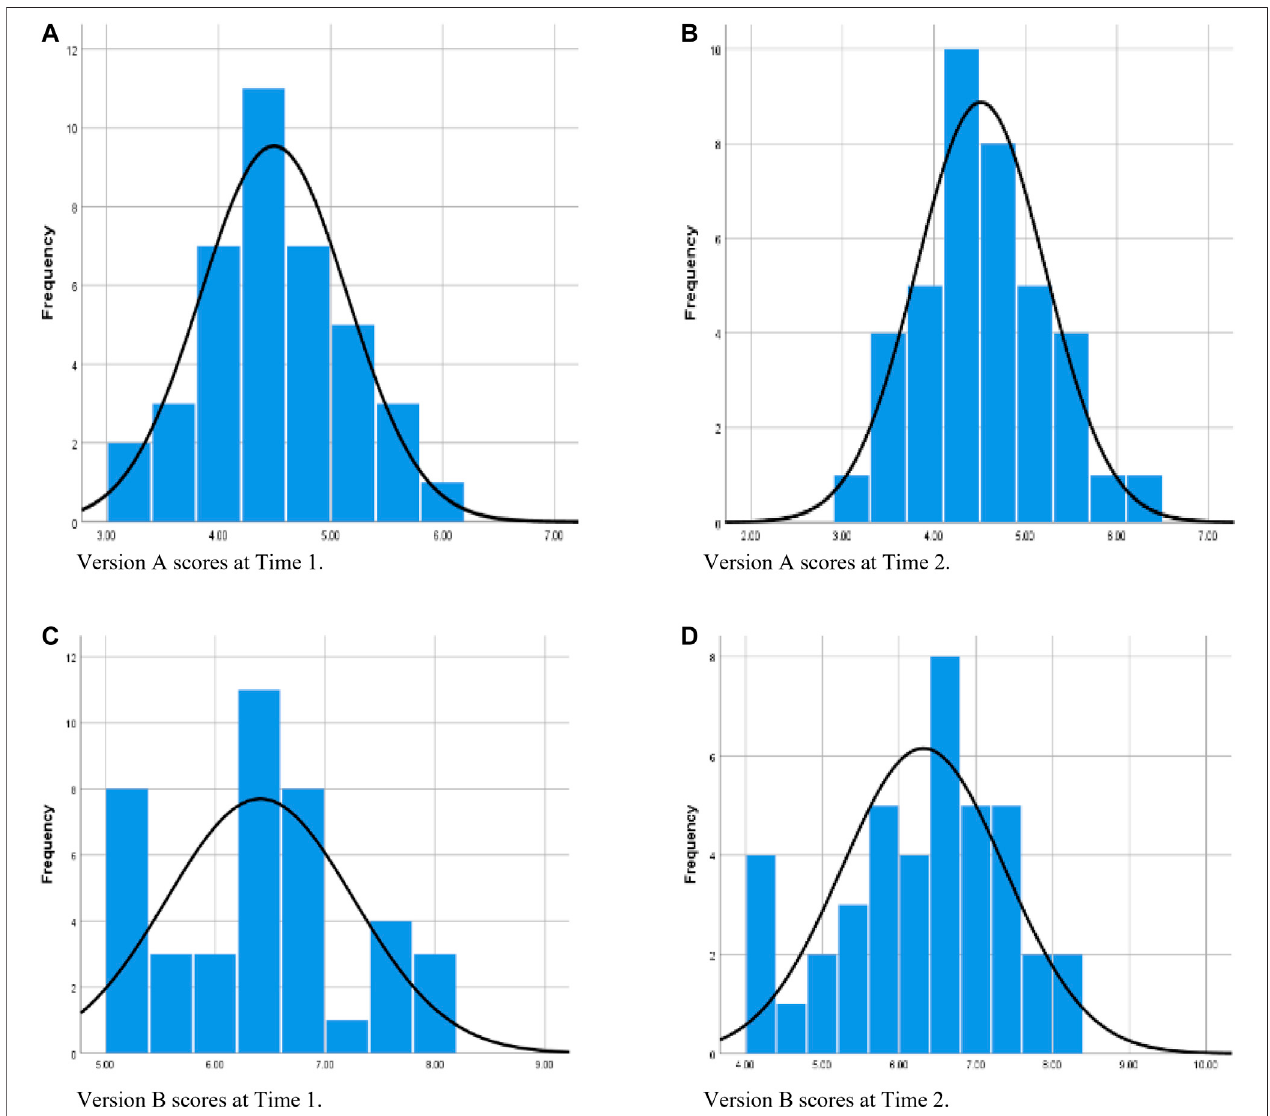
FIGURE 2 | Distribution of composite scores on each version on each occasion ofmeasurement after winsorizing data where considered necessary. (Version A at Time 2 was not subjected to winsorizing; it is included in this set of fi gures to facilitate comparisons.)